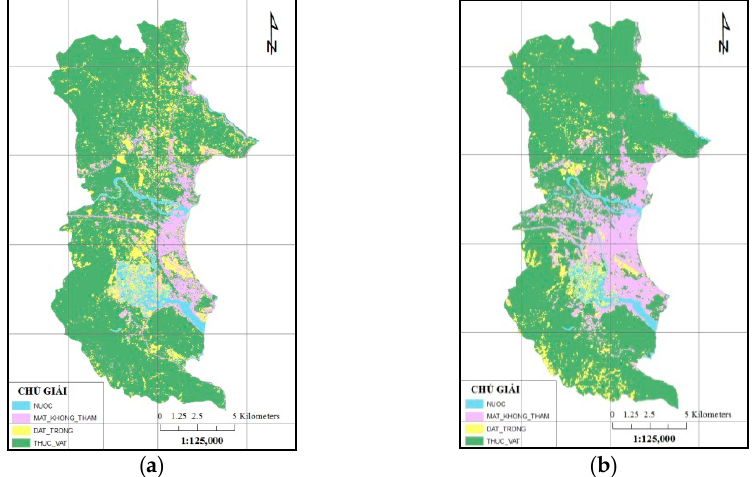
Figure 2. Distribution of Land cover of Nha Trang city. ( a ) Land cover in 2007; ( b ) Land cover in